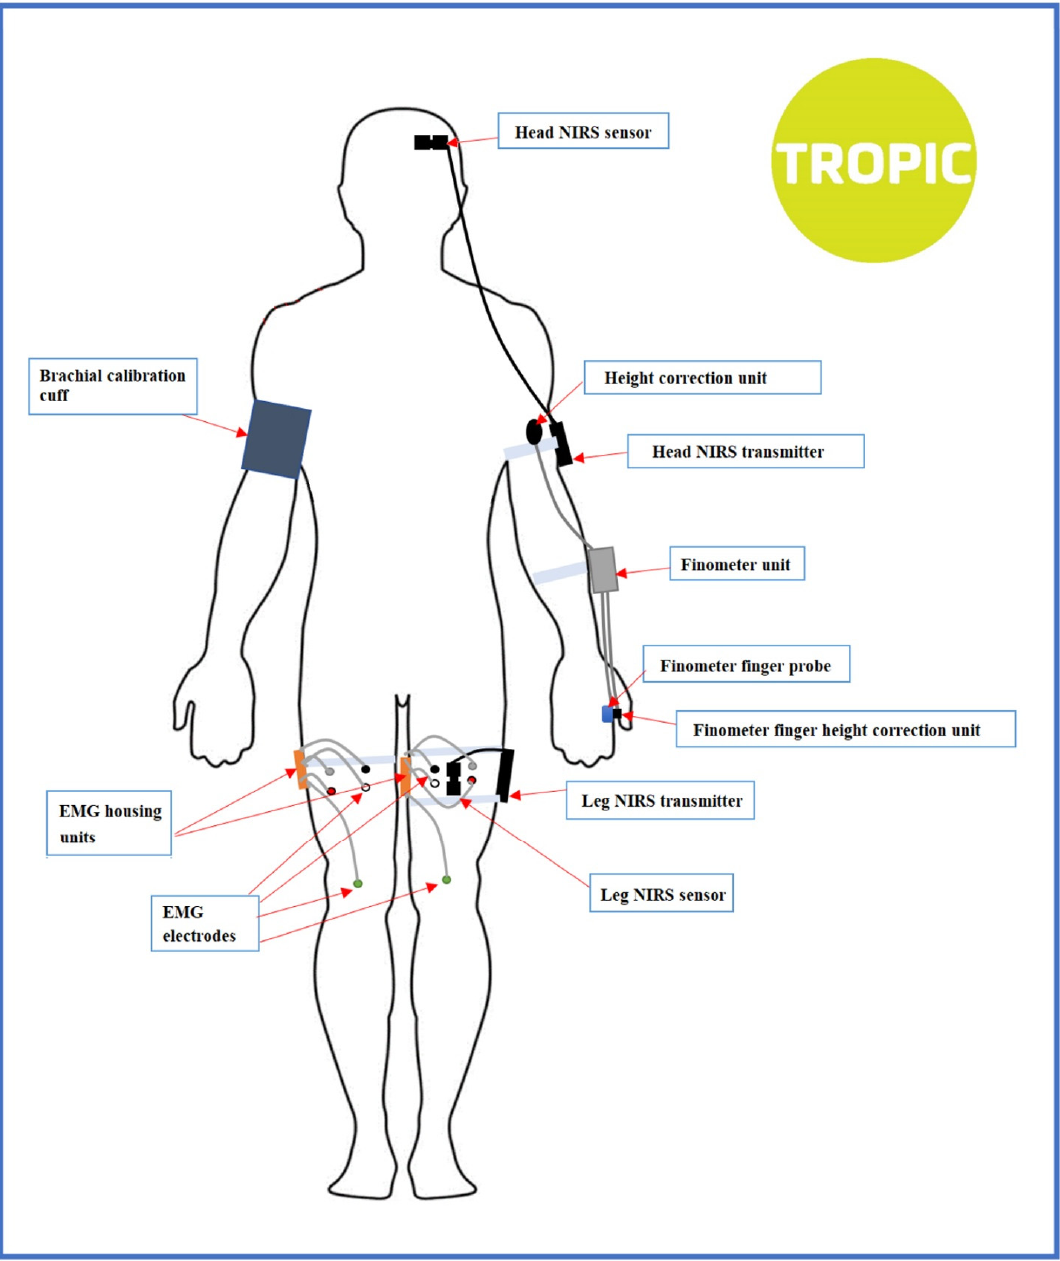
Figure 2. Sensor attachment diagram for the NCVI/NMFI assessment. A total of 6 modules with 15 sensors were attached to each of the participants.